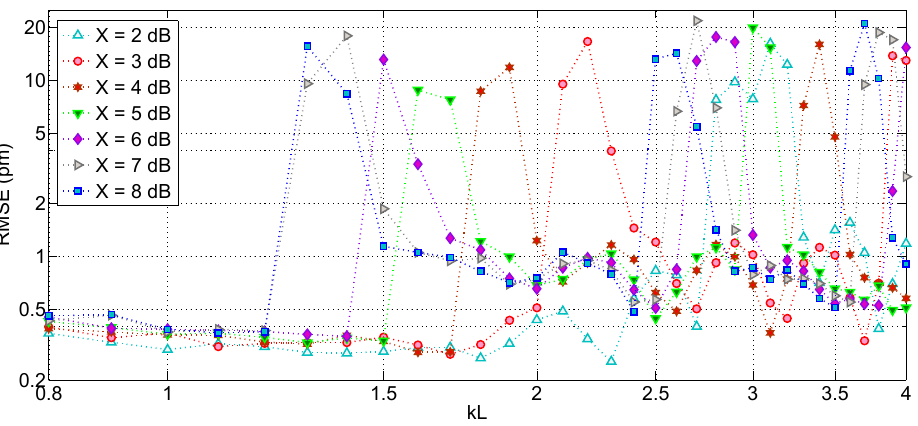
Figure 18. Sensitivity of bandwidth-tracking method to grating strength kL and threshold selection X . The chart reports RMSE ( kL ) for several values of X .